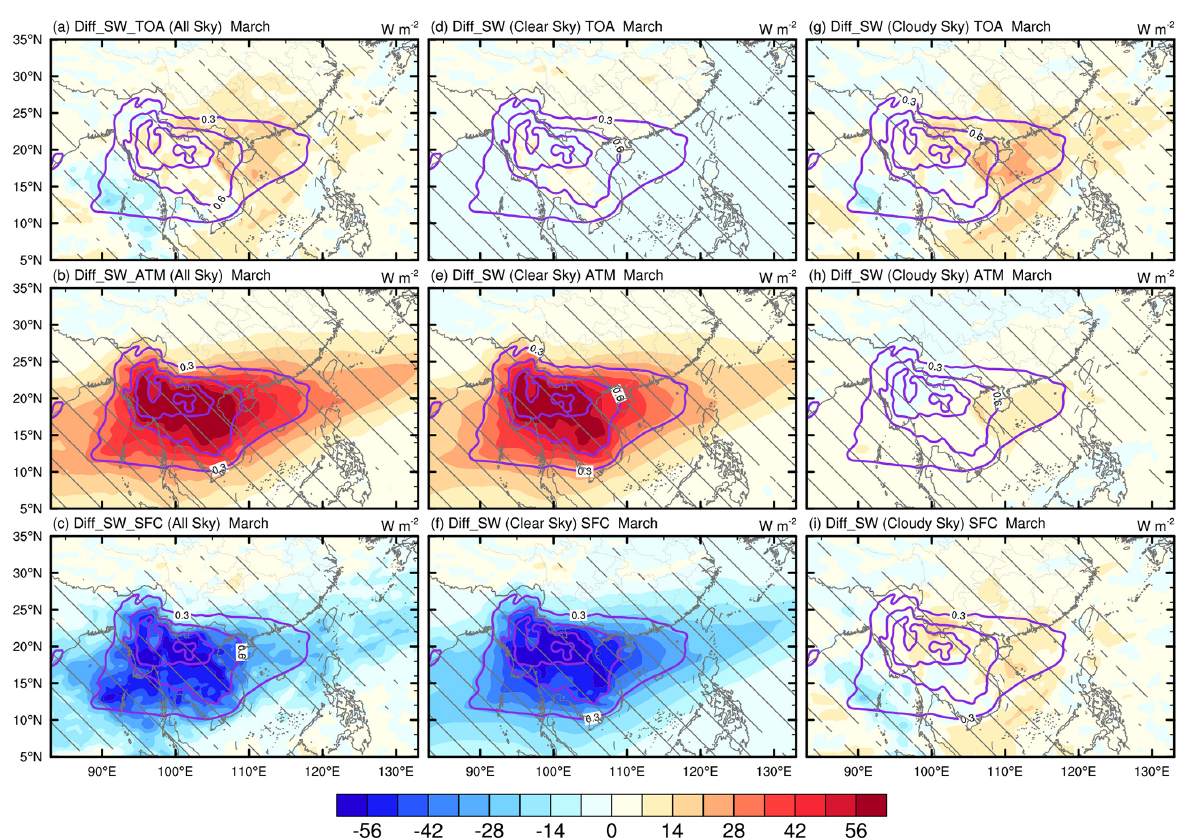
Figure 6. (a–c) Differences (CTRL minus BBER) in all-sky net downward shortwave radiative flux (shading; Wm − 2 ) (a) at the top of the atmosphere (TOA), (b) in the atmosphere (ATM), and (c) at the surface (SFC) in March 2010. (d–f) and (g–i) : same as (a) – (c) but for clear- sky and cloudy-sky differences, respectively. The purple contours with an interval of 0.3 denote AOD differences (CTRL minus BBER). Hatching denotes that the radiative effect is statistically significant at the 95% confidence level based on a Student’s t